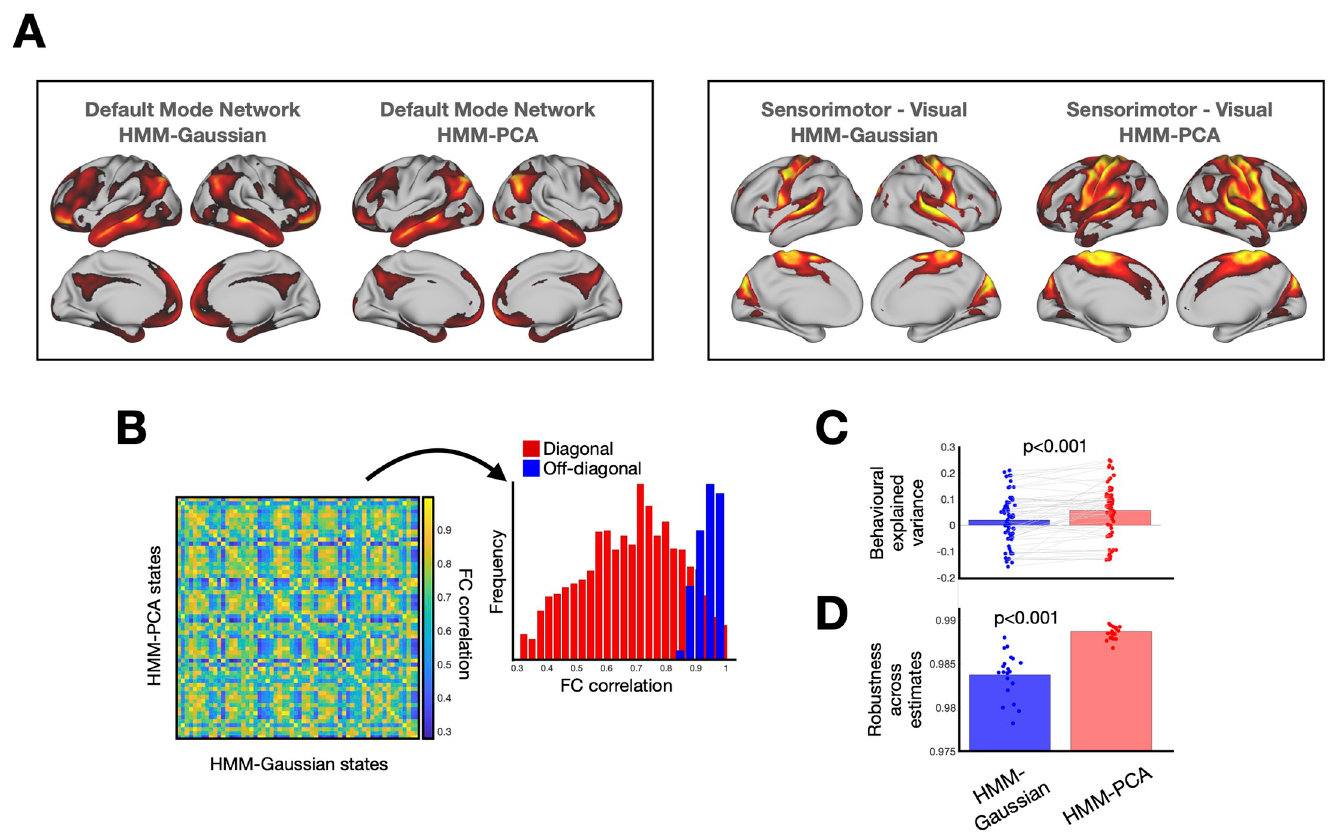
Fig 5. Comparison of HMM-Gaussian and HMM-PCA on resting-state data from 820 Human Connectome Project subjects. A . Two example states per model, default mode network and sensorimotor-visual, where the maps reflect the degree, i.e. the total amount of connectivity between each voxel and the rest of the brain. B . The states are relatively comparable across the two models. Left: Correlation matrix between the HMM-PCA and the HMM-Gaussian states (in terms of Pearson’s correlation between the off-diagonal elements of the states’ FC matrices) across 5 runs of the inference. Right: Distribution of the diagonal elements (red) and off- diagonal (blue) elements, where the red elements reflect the similarity between corresponding states (i.e. an HMM-PCA state and an HMM-Gaussian state that correspond to each other), and the blue elements reflect the similarity between non-corresponding states. C . HMM-PCA produces solutions that are more explanatory of behaviour. Using the fractional occupancy across runs (i.e. the amount of time spent on each state), the HMM-PCA models are better able to predict behavioural traits across a range of demographical, intelligence, personality and affective-related variables; each dot represent the explained variance (in terms of Pearson’s correlation) for the cross-validated prediction of one behavioural trait, and the bars represent the average across traits. D . HMM-PCA produces solutions that are more robust than HMM-Gaussian across repetitions of the inference; robustness is here measured as the capacity to predict (using cross-validation) the state time courses of one HMM estimate using the state time courses of another HMM